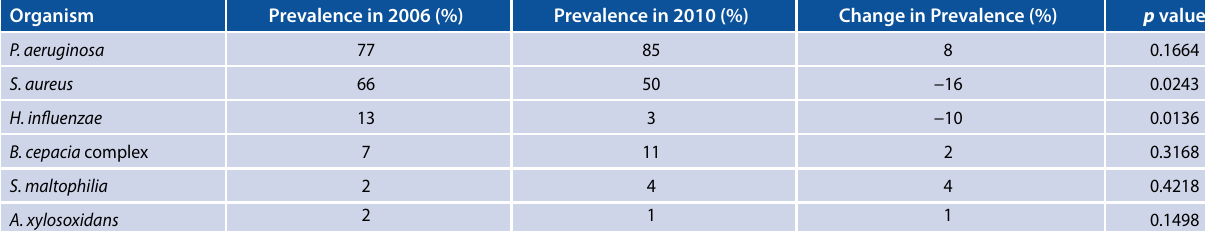
Table 2: Change in prevalence of bacterial pathogens between 2006 and 2010